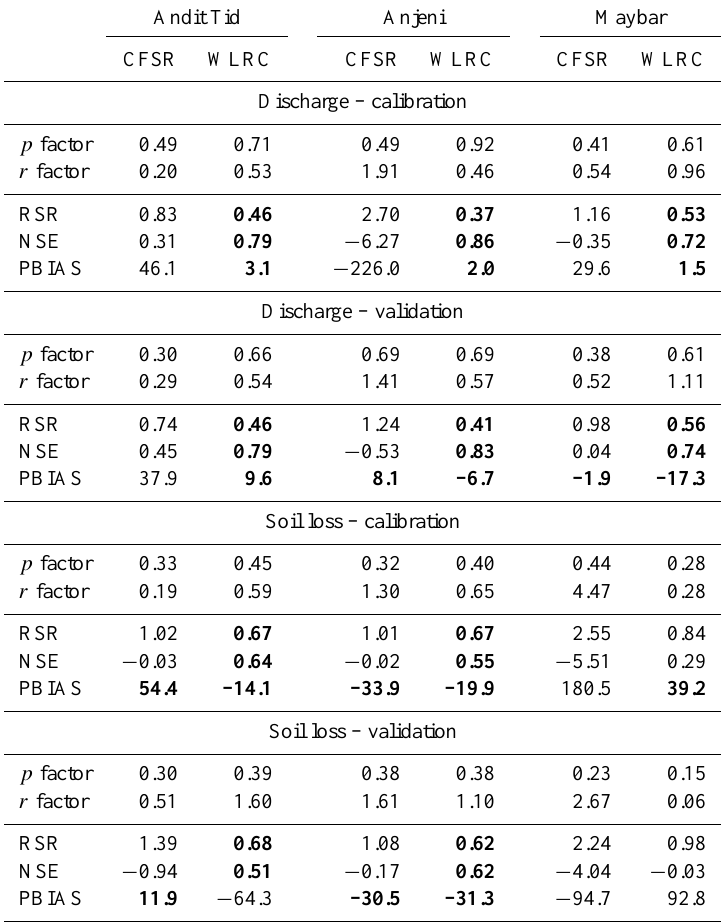
Table 5. Calibration and validation results of monthly CFSR- and WLRC-modelled discharge and soil loss. Values that meet at least the satisfactory criteria are highlighted in bold. Andit